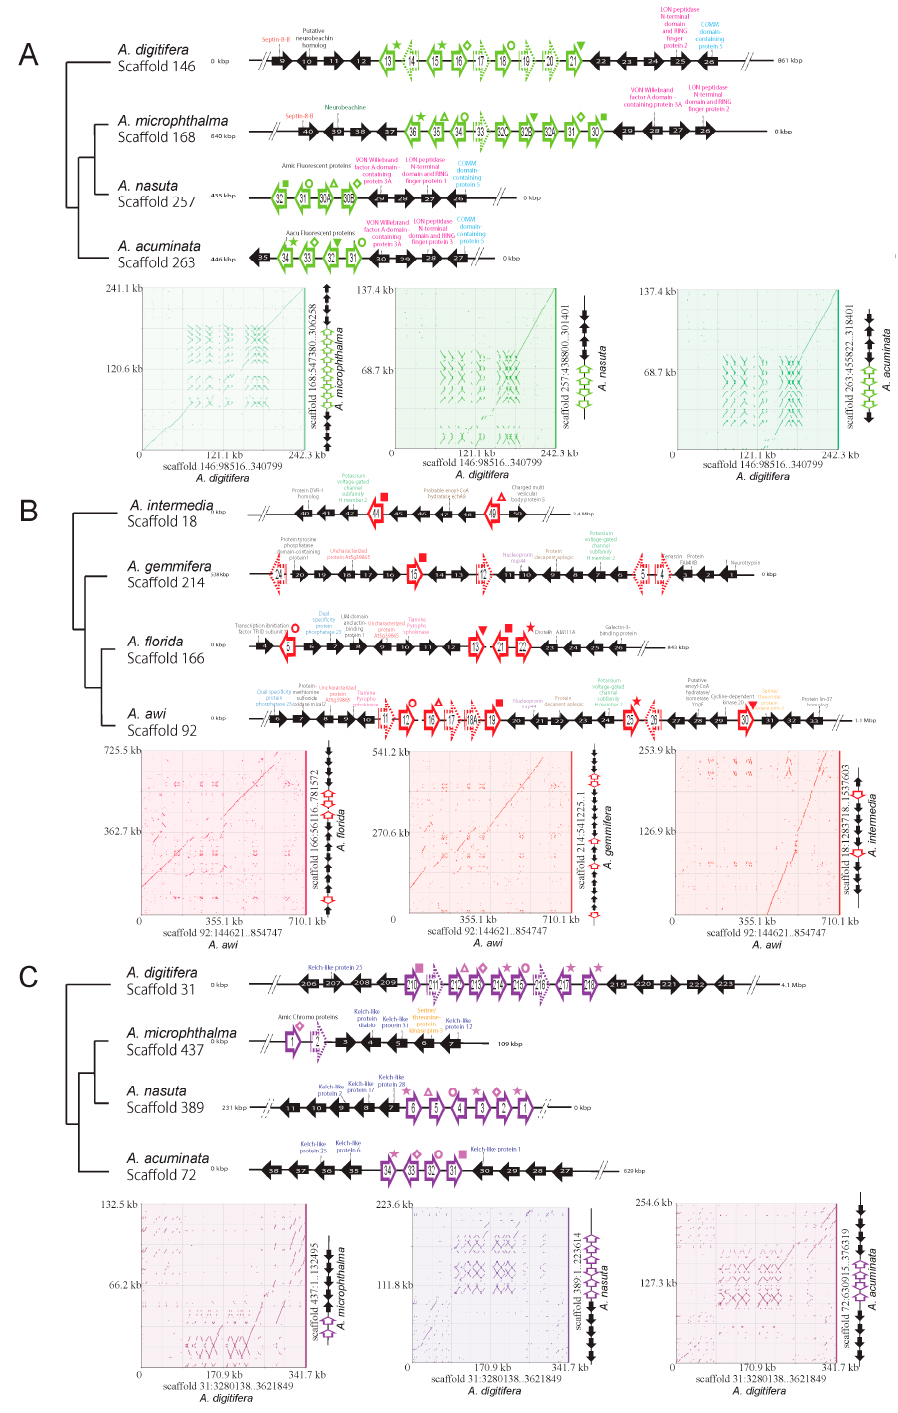
Figure 3. Three core gene clusters, including nine FP genes and syntenic regions in Acropora genomes. Synteny analysis showed the probability of extensive tandem gene duplications or losses at three genomic locations in the Acropora lineages. ( A ) GFP/CFP (green arrow) gene clusters in Clade III Acropora ( A. digitifera, A. nasuta, A. microphthalma, and A. acuminata ). ( B ) RFP (red arrow) clusters in Clade II ( A. intermedia, A. gemmifera, A. awi, and A. florida ). ( C ) ChrP (purple arrow) clusters in Clade III ( A. digitifera, A. nasuta, A. microphthalma, and A. acuminata ). The clades correspond to Figure 2. The orthologous relationships between species are shown as symbols ( (cid:70) , , (cid:4) , , and (cid:52) ) that correspond to Figure S5. The standard arrow (cid:35) (cid:51) indicates predicted complete FP genes (Table S2), and the dashed arrow indicates the predicted incomplete FP genes from this study (Table S1). Black arrows indicate neighboring genes to FPs